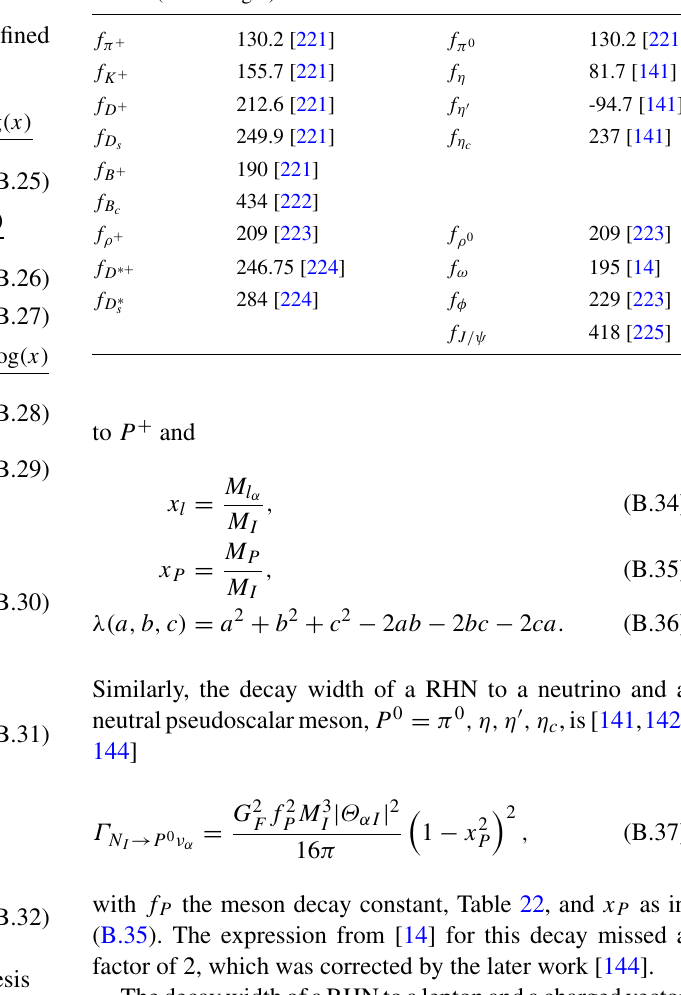
Table 22 Decay constants (in MeV) of pseudoscalar charged (top left), pseudoscalar neutral (top right), vector charged (bottom left) and vector neutral (bottom right)